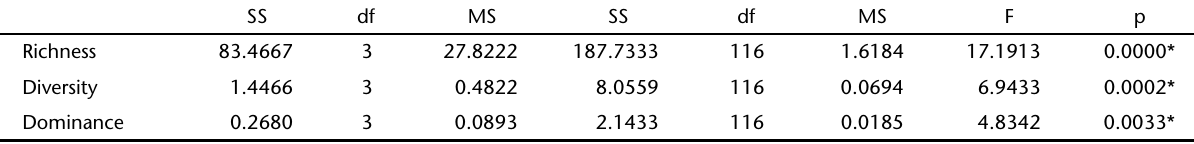
Table III. Analysis of variance. F and p values for richness, diversity and dominance variables related to the four study stations (N = 30 samples/station).